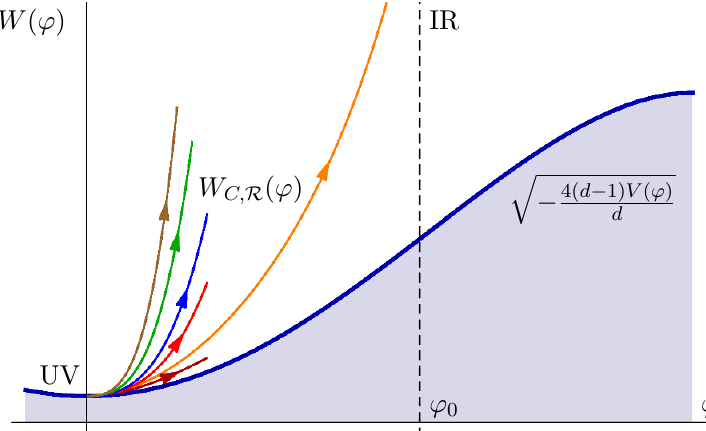
Figure 1. Family of solutions W C; R ( ’ ) in the vicinity of a UV (cid:12)xed point located at a maximum of the potential. For a (cid:12)eld theory with a given UV value of the source and (cid:12)xed R uv only a (cid:12)nite number of these solutions (here only one) can be completed into a (cid:13)ow reaching an IR end point at ’ 0 . The shaded region below the blue curve is not accessible for R uv (cid:21)